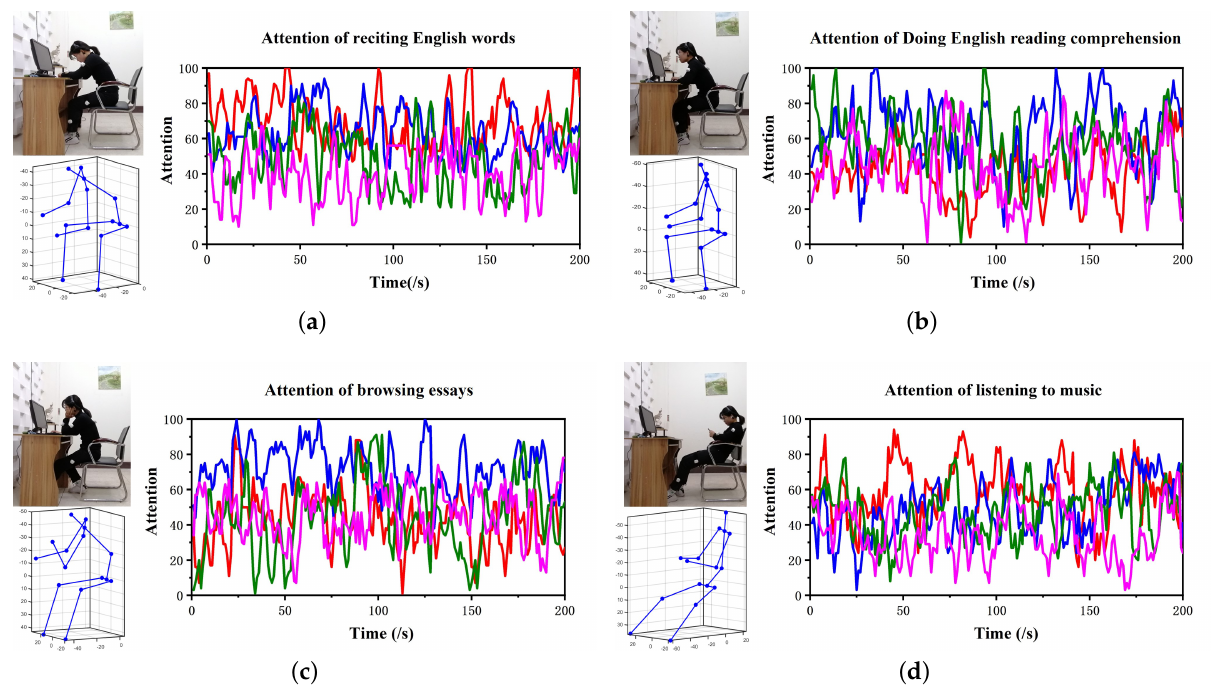
Figure 19. Raw data of concentration of 4 × 4 experimental conditions. ( a ) Attention of reciting English words. ( b ) Attention of doing English reading comprehension. ( c ) Attention of browsing essays. ( d ) Attention of listening to music. The left is the experimental task, and the right is the raw data of the participants’ brain